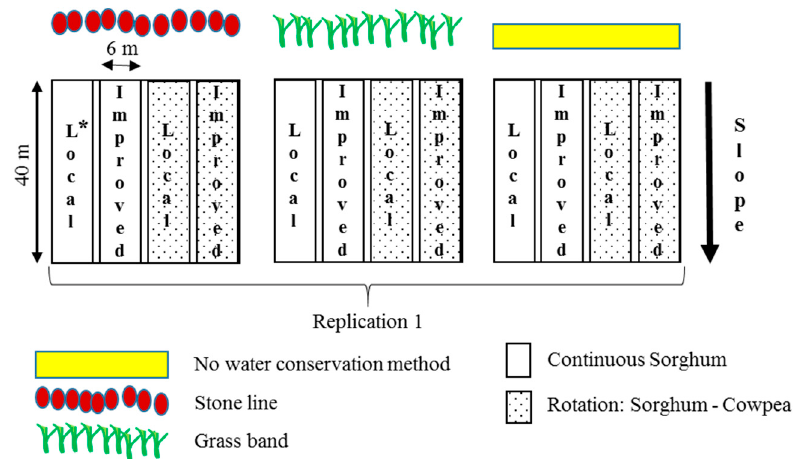
Figure 2. Experimental design. There were four replicates with the water conservation method (WCM), cropping systems, and randomized genotype treatments. *Local sorghum landrace Nongomsoba or local cowpea variety/improved sorghum variety Sariaso 14 or improved cowpea variety KVX 396-4-4.